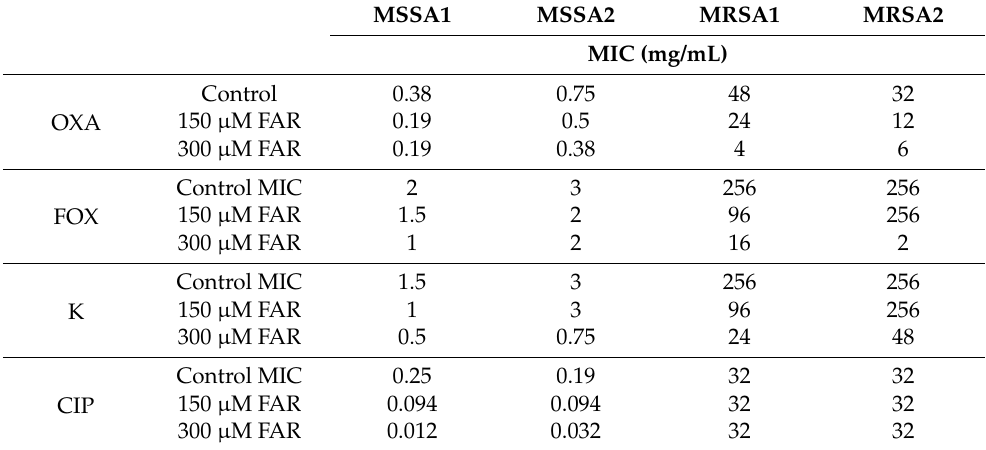
Table 4. Effect of FAR (150 and 300 µ M) on the Antibiotic Susceptibility Profile of S. aureus